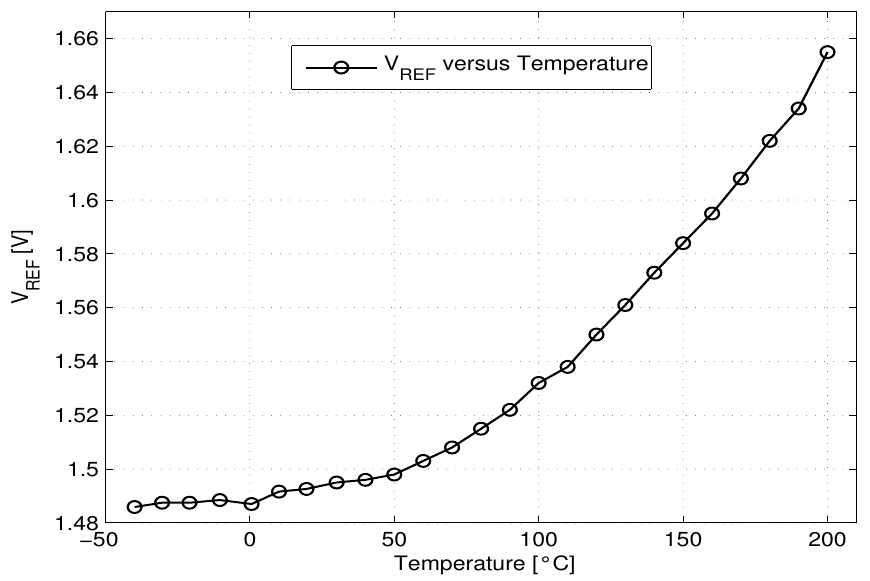
versus temperature. REF